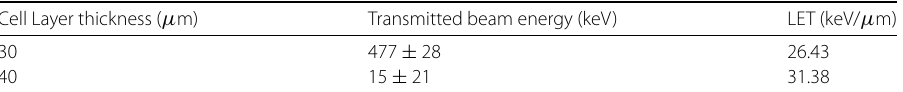
Table 1 SRIM simulations [11] of transmitted beam energy in the cell layer for an entrance energy of 1.27 MeV protons (simulation n° of particles = 1000; values are x ± SD) and the corresponding value of LET Cell Layer thickness ( μ m) Transmitted beam energy (keV) LET (keV/ μ m)